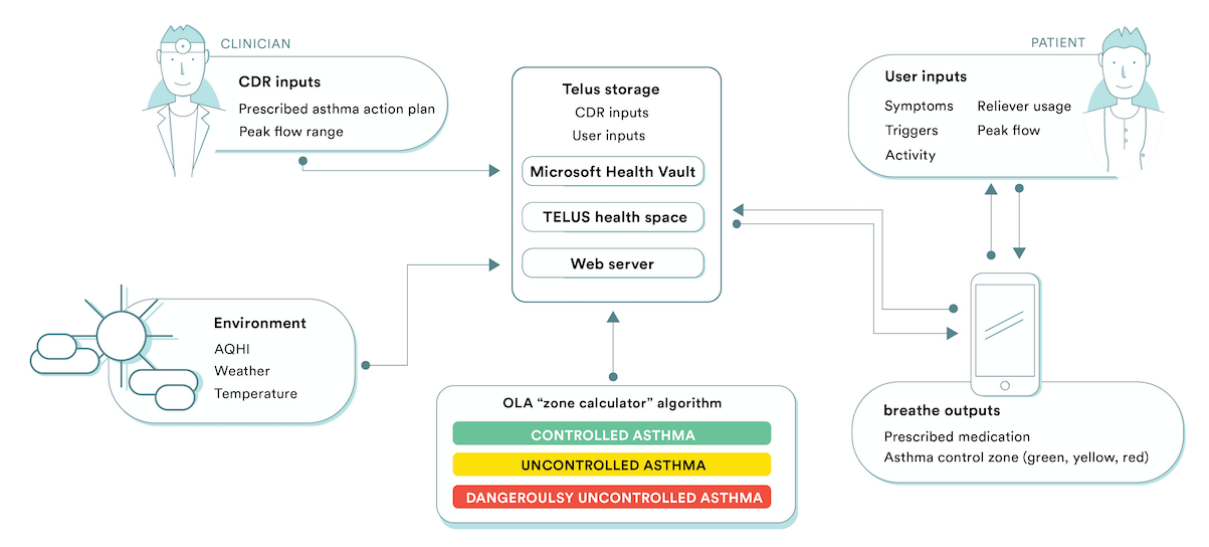
Figure 2. Architecture of the breathe platform (Ontario Lung Association [OLA], Air Quality Health Index [AQHI], Clinical Data Repository [CDR]). In cases where peak flow was part of the action plan, peak flow ranges were entered by the provider. Patients were responsible for entering peak flow